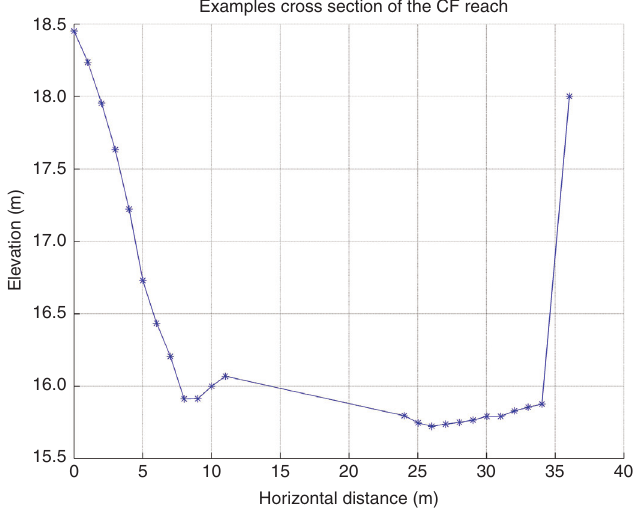
Figure 6. Example Cross Section of the CFR. The Locations of the Measurement Are Shown with Dots, and the Cross Section Is Interpolated (Straight Line) between Them.